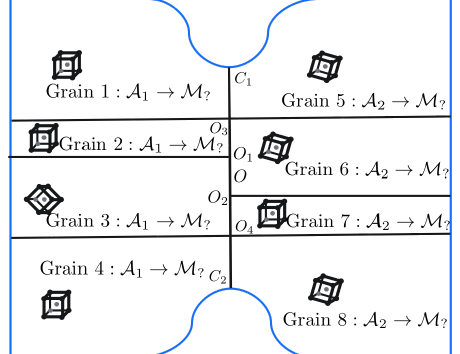
Figure 4. Schematic of the grain structure within martensite band that emanate from the underlying (prior) austenite. The martensite variant, to which the austenite transforms, needs to be identified based on the criticality requirement mentioned earlier. The values of OO 1 = OO 2 = 0.06 L Y , OO 3 = OO 4 = 0.15 L Y and OC 1 = OC 2 = 0.25 L Y are